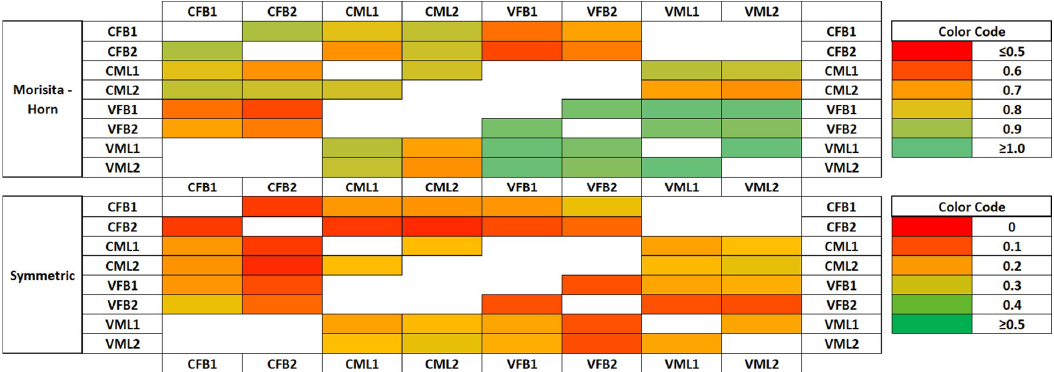
Figure 1. Heat map of β‐diversity indices of pair of biological samples of interest (CFB: Constant salinity Fixed Biofilm, CML: Constant salinity Mixed Liquor, VFB: Variable salinity Fixed Biofilm, VML: Variable salinity Mixed Liquor).